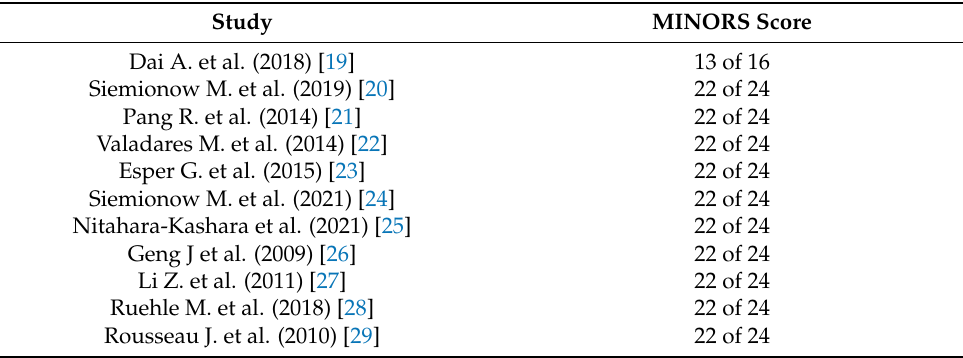
Table 2. MINORS score of selected